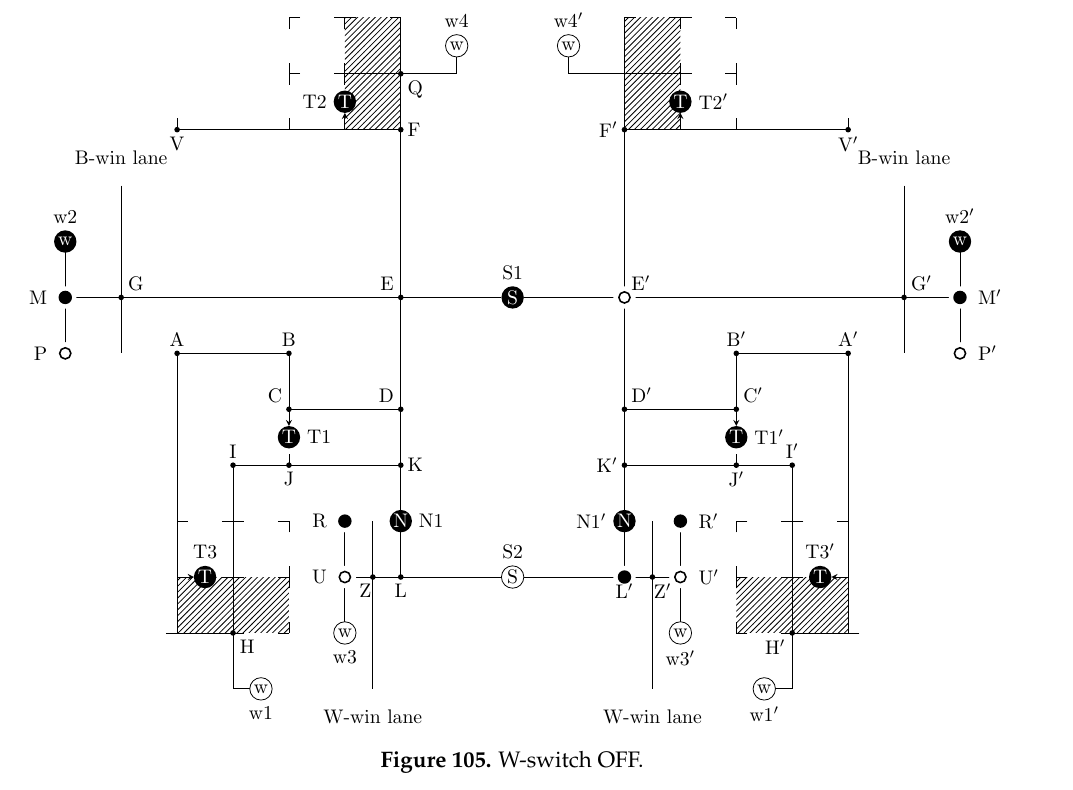
Figure 105. W-switch